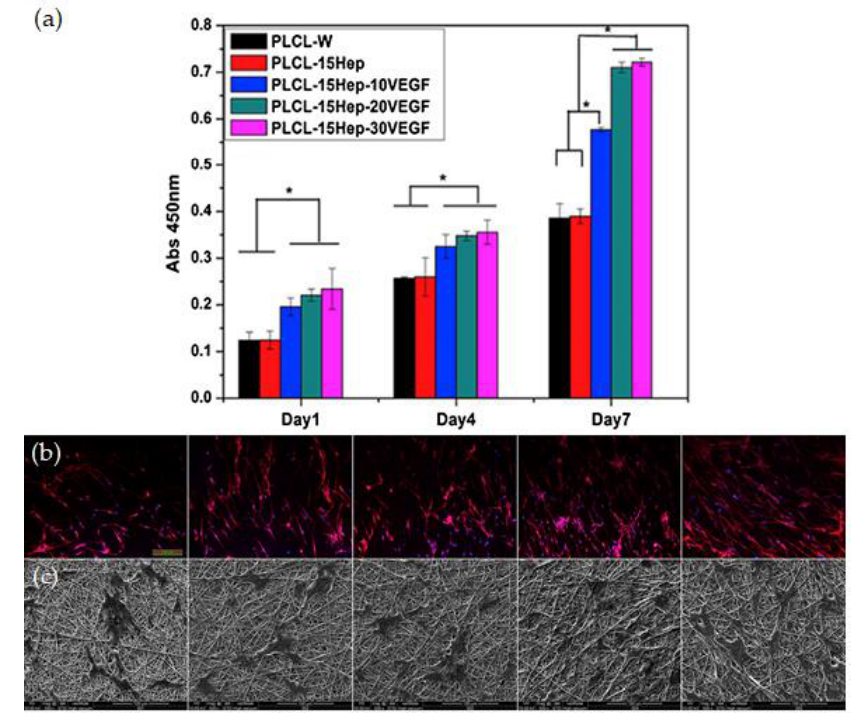
Figure 3. ( a ) Endothelial progenitor cell growth from 1 to 7 days (PLCL-W, control without biomolecules; 15Hep, 15 wt% heparin; 10, 20 and 30 vascular endothelial growth factors (VEGF) represent 10, 20 and 30 µ g / mL of VEGF) and visual detection of the cells via ( b ) immunofluorescent microscopy (scale 200 µ m) and ( c ) scanning electron microscopy (SEM, scale 100 µ m) (adapted with permission from [162]).